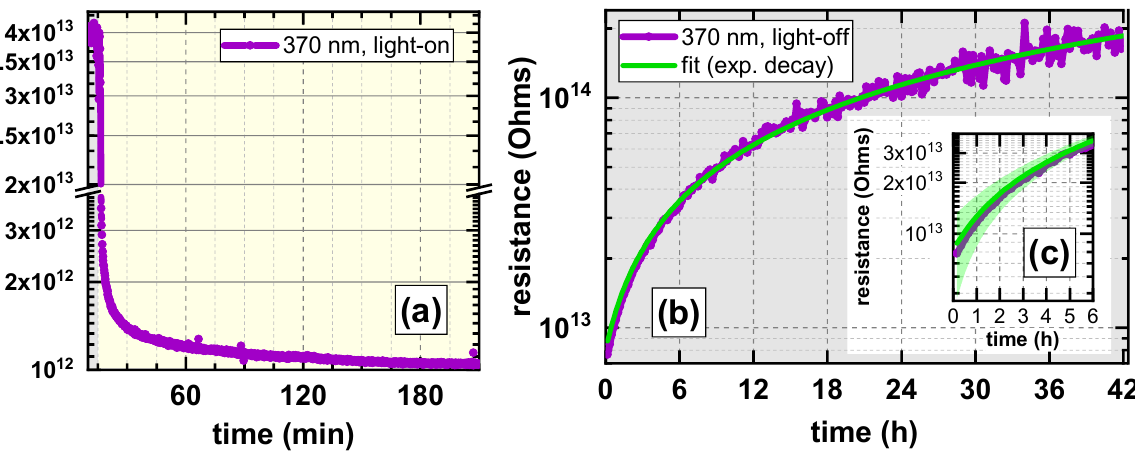
Figure 7. Long-term transients of the resistance as acquired exemplarily upon 370 nm super-bandgap illumination: ( a ) Light-on transient recorded for more than 3 h; ( b ) tail of the light-off transient recorded for 42 h with a single-exponential fit indicating a time constant in the range of 213 h or approximately 9 days (equivalent to a “half-life” time constant of 6 days) with inset ( c ) showing a close-up view of the fit and 95%-confidence bands for the time regime short after shadowing the